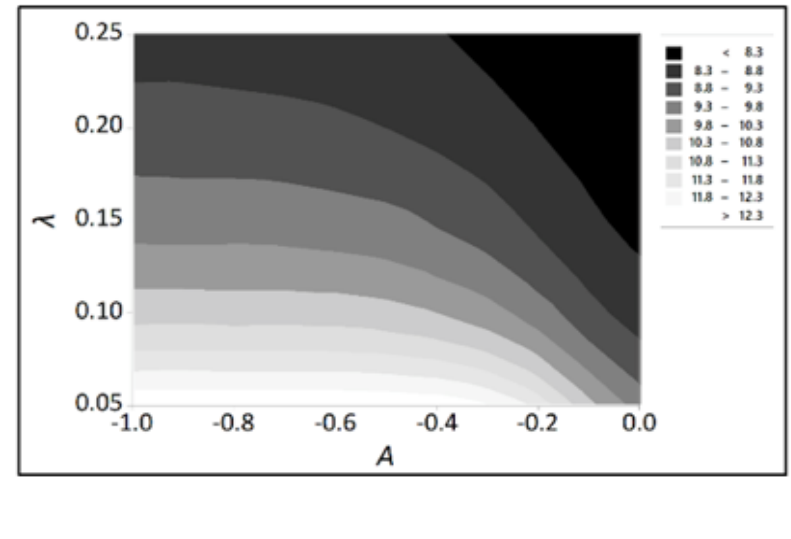
Fig. 7. Weighted 𝐀𝐑𝐋 performances for weighting functions: a. 𝛂 = 𝛃 = 𝟐 ; b. 𝛂 = 𝟐 , 𝛃 = 𝟓 , c. 𝛂 = 𝟓 𝟏 and 𝛃 =